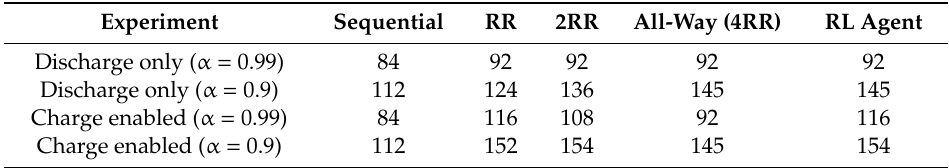
Table 2. Battery scheduling results using various scheduling algorithms under the simulation setup in this work, electrical-only environment. Unit: minutes.